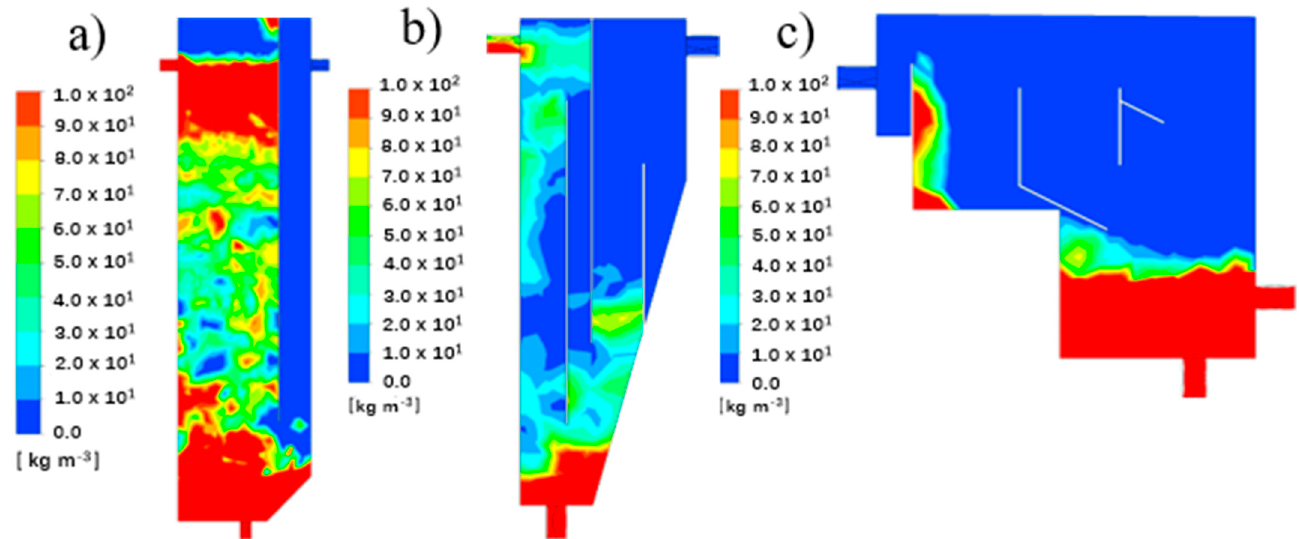
Figure 4. The particle distribution contour plots of R1 ( a ), R2 ( b ) and R3 ( c ).